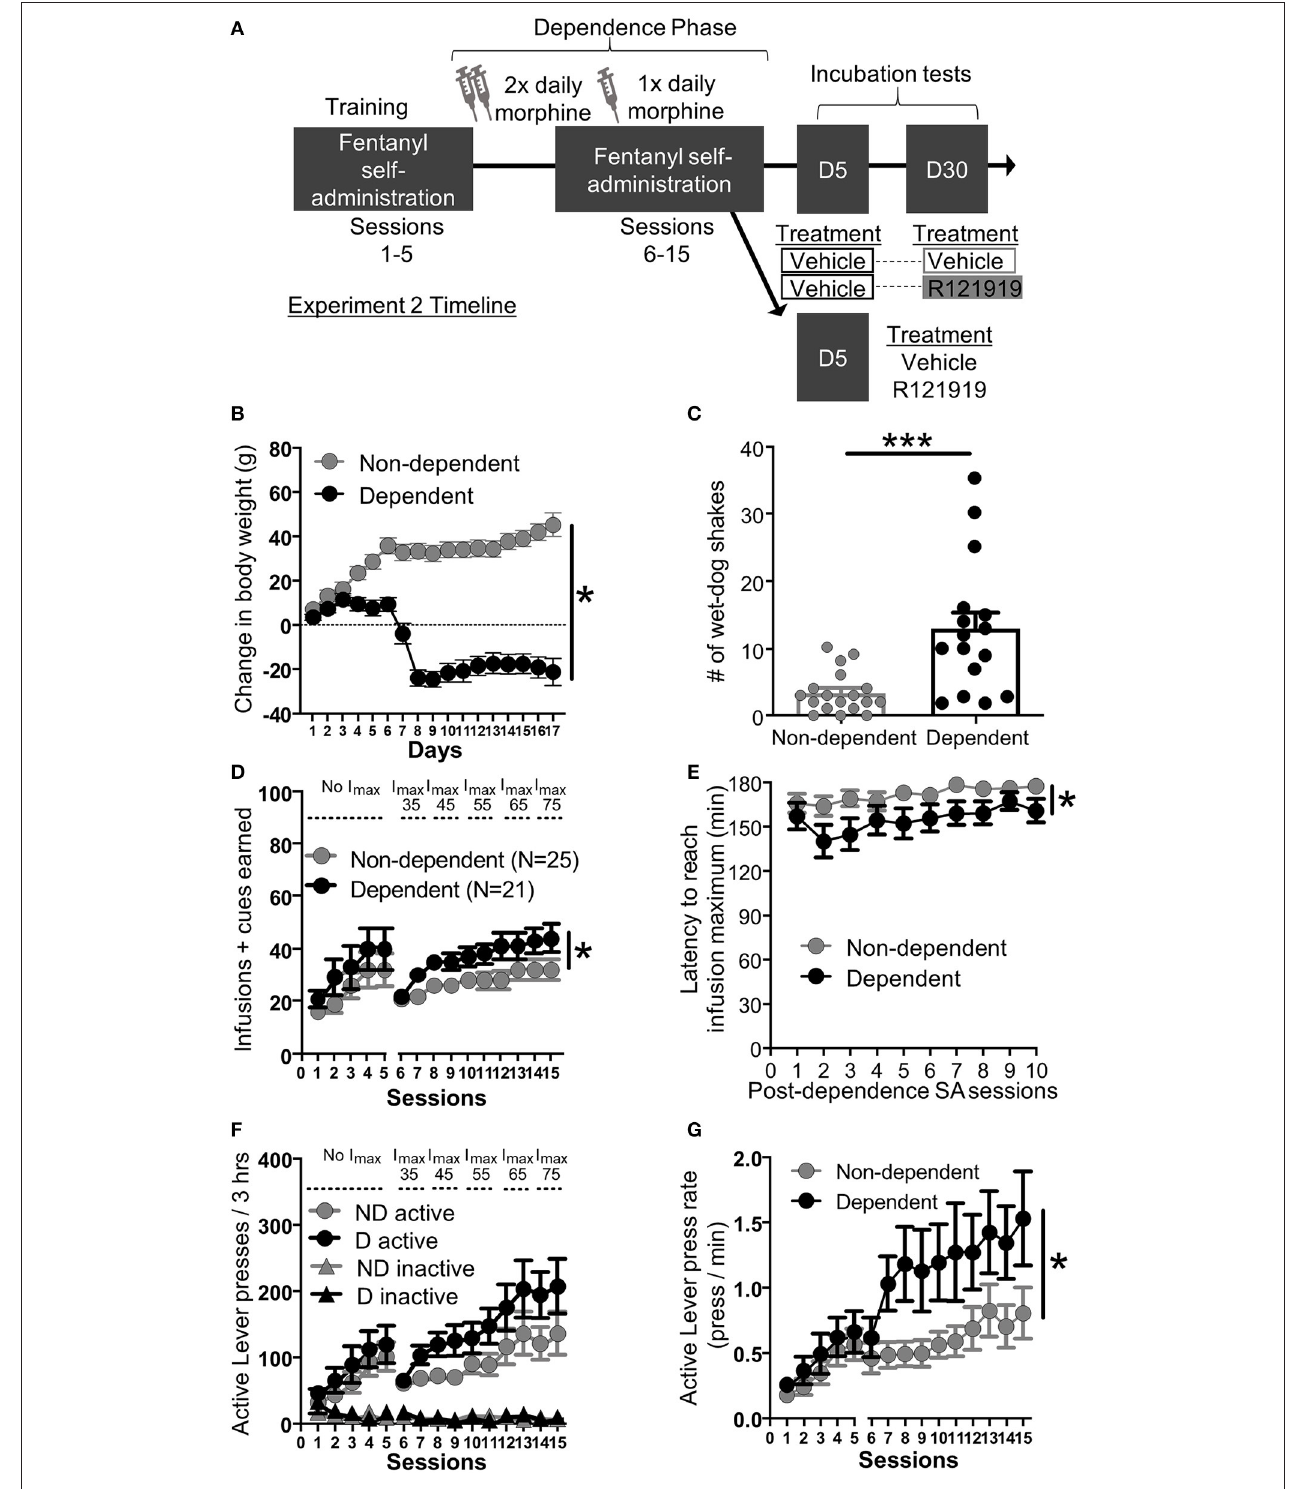
FIGURE 2 | Experiment 2: Fentanyl self-administration training in opioid dependent versus non-dependent rats. (A) Experimental timeline: We trained rats to self-administer fentanyl for 5 days before inducing opioid dependence. Rats resumed self-administration for 10 more days while dependence was maintained. On forced abstinence Day 5 and Day 30, we measured lever responding under extinction conditions. (B) Change in body weight across days for opioid-dependent and non-dependent rats after start of dependence phase. (C) Number of wet-dog shakes for opioid-dependent and non-dependent rats. (D) Fentanyl infusions +